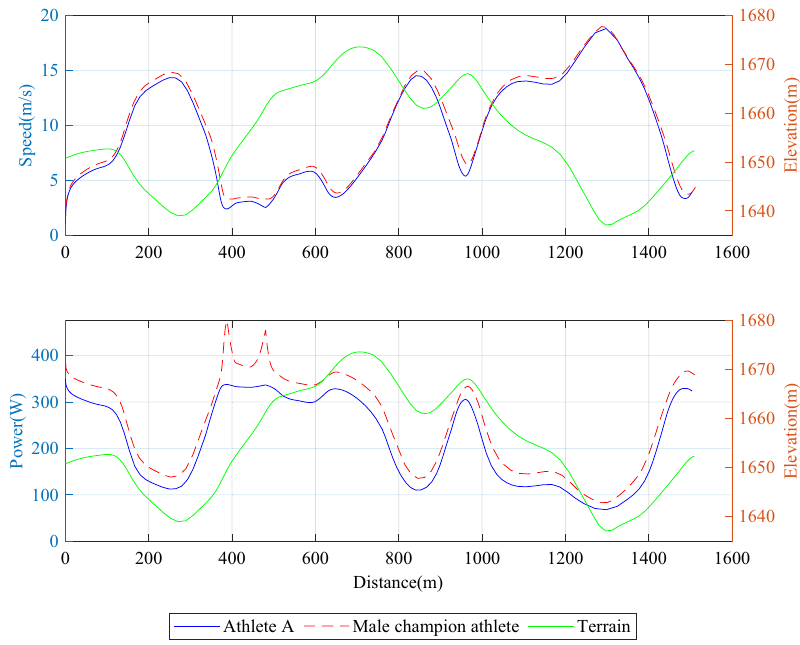
Figure 13. Global speed and driving power distribution of athlete A and champion